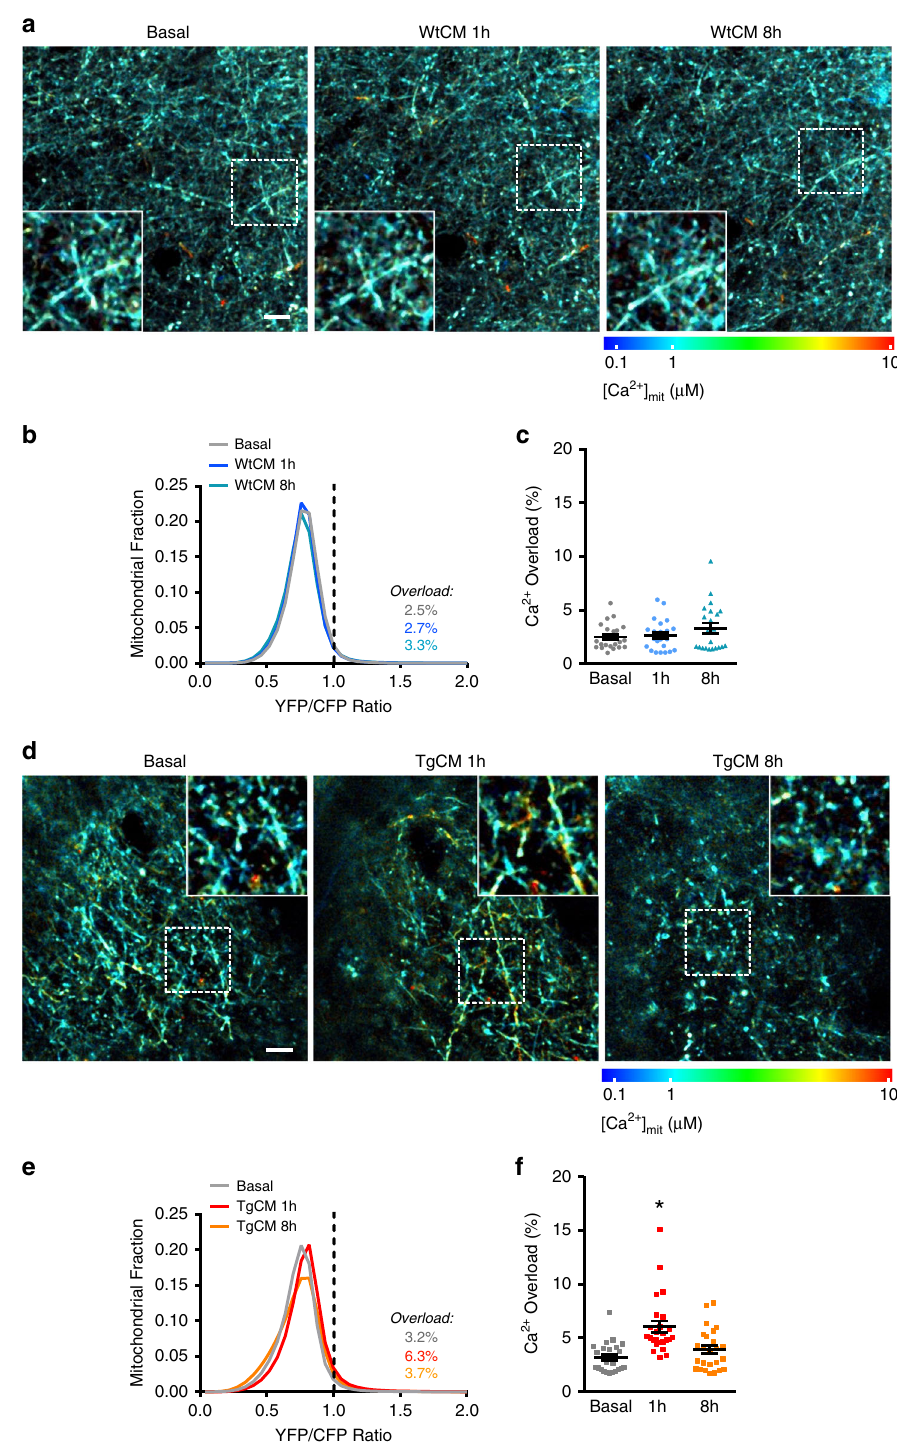
Fig. 6 Soluble A β -driven mitochondrial Ca 2 + increase recovers after 8 hours post-application. a Time-lapse images showing mitochondrial [Ca 2 + ] increase induced by WtCM, in basal conditions, 1 and 8 h after topical application. Scale bar 20 µ m. b Histogram of [Ca 2 + ] mit frequency distribution (YFP/CFP ratio) before and 1 or 8 h after application of WtCM. The black dotted line corresponds to 2SD above the mean [Ca 2 + ] mit measured for all mitochondria before treatment. Ratios above this line were classi fi ed as mitochondrial Ca 2 + overload. c Scatter dot plot represents the percentage of mitochondria with Ca 2 + overload at each time point in every volume acquired. Bars errors represent mean ± SEM (Basal 2.5 ± 0.54%, 1 h 2.7 ± 0.54%; 8 h 3.3 ± 0.54%; non-signi fi cant, n = 22 z -stacks from 3 mice). d Time-lapse images showing mitochondrial [Ca 2 + ] increase induced by TgCM, in basal conditions, 1 and 8 h after application. Scale bar 20 µ m. e Histogram of [Ca 2 + ] mit frequency distribution (YFP/CFP ratio) before and 1 or 8 h after application of TgCM. Note that [Ca 2 + ] mit distribution is shifted to higher YFP/CFP ratios at 1 h post- TgCM application, but recovers at 8 h post-TgCM application. f Scatter dot plot represents the percentage of mitochondria with Ca 2 + overload at each time point in every volume acquired. Error bars represent mean ± SEM (Basal 3.2 ± 0.60%, 1 h 6.3 ± 1.22%; 8 h 3.7 ± 0.70%; * p < 0.05 vs. basal, n = 25 z -stacks from 5